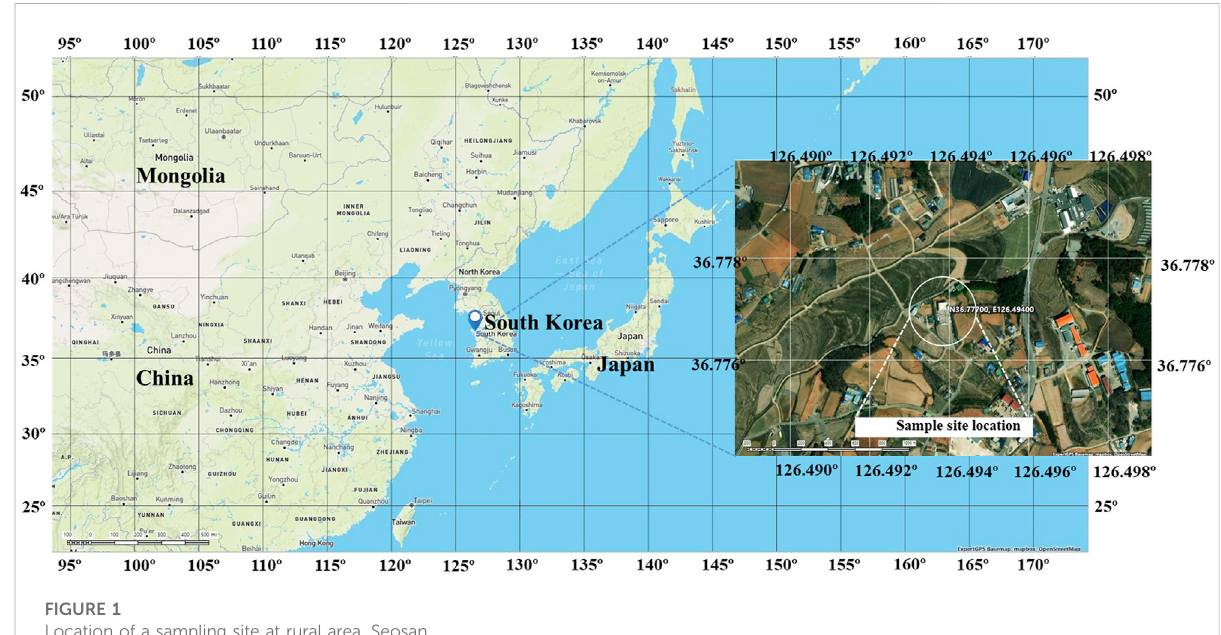
FIGURE 1 Location of a sampling site at rural area,